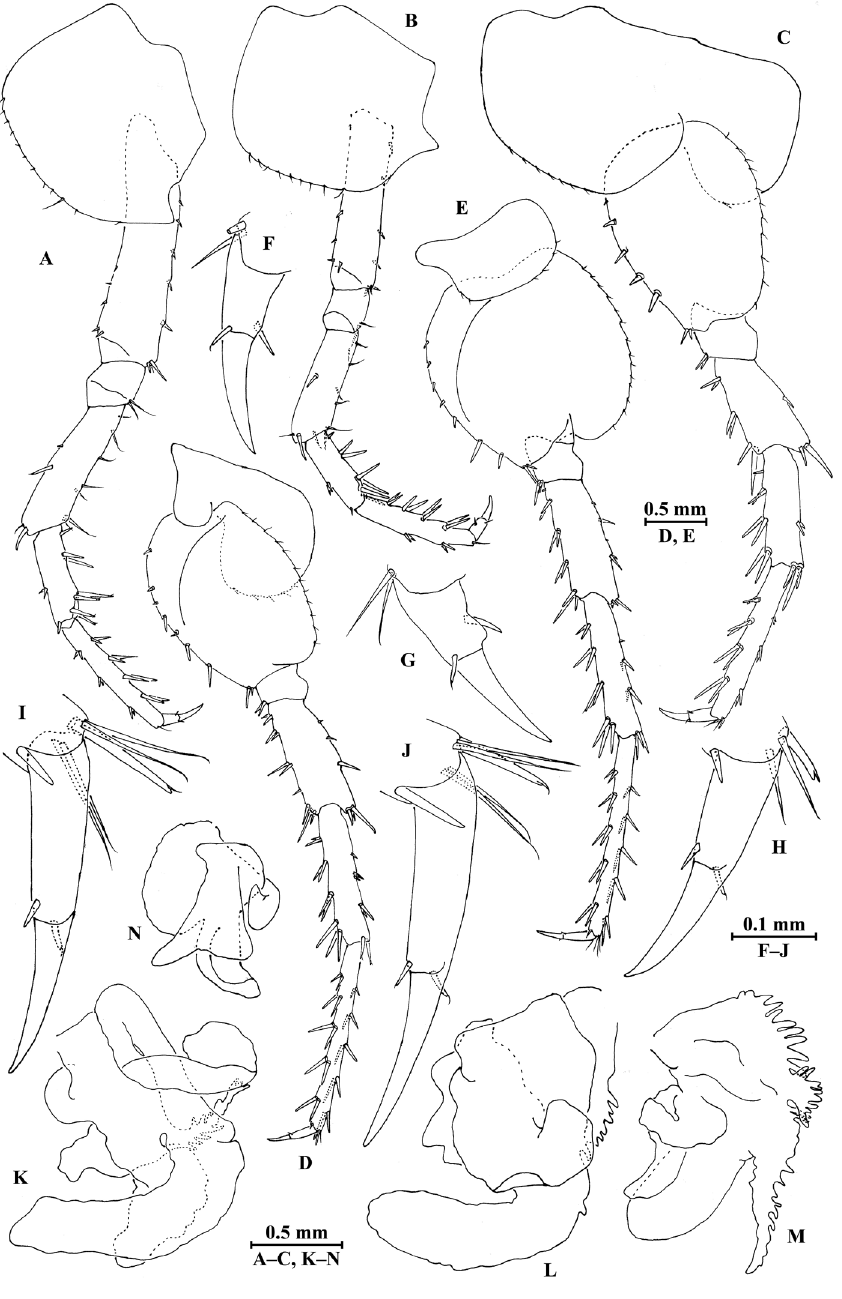
Figure 9. Myanmarorchestia seabri Hou, sp. n., male holotype. A pereopod III B pereopod IV C pereo- pod V D pereopod VI E pereopod VII F dactylus of pereopod III G dactylus of pereopod IV H dactylus of pereopod V I dactylus of pereopod VI J dactylus of pereopod VII K coxal gill of pereopod III L coxal gill of pereopod IV M coxal gill of pereopod V N coxal gill of pereopod